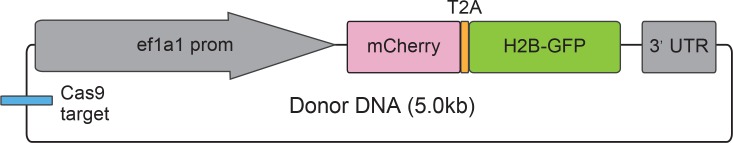
Structure of a donor plasmid for the knock-in at the Dma-ey locus.The Thosea asigna virus 2A (T2A) peptide connected the mCherry marker with a fusion protein comprising histone 2B (H2B) connected to green fluorescent protein. The ef1a1 promoter/enhancer was inserted upstream from the T2A reporter cassette. The Cas9 target site (gRNA-2 recognition site) was derived from Dma-ey exon 10.